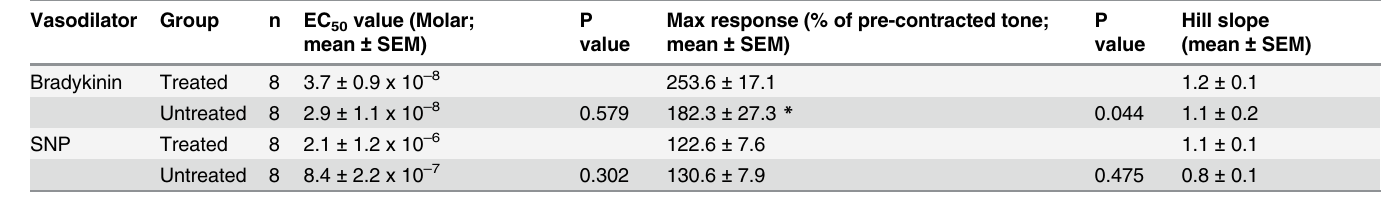
Table 1. EC 50 values and maximum responses derived from arthritic sheep coronary artery responses, showing the effect of mesenchymal pre- cursor cell treatment on dilation caused by endothelium-dependent and-independent vasodilators. Vasodilator Group